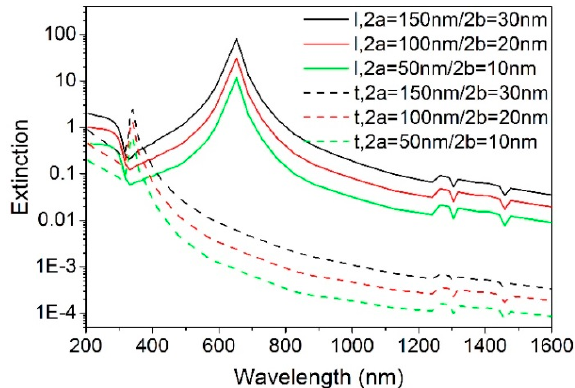
Figure 13. The calculated extinction spectra of a single silver nanorod with a constant aspect ratio of 5, the length 2 a = 150, 100, and 50 nm, correspondingly, the diameter 2 b = 30, 20, and 10 nm.